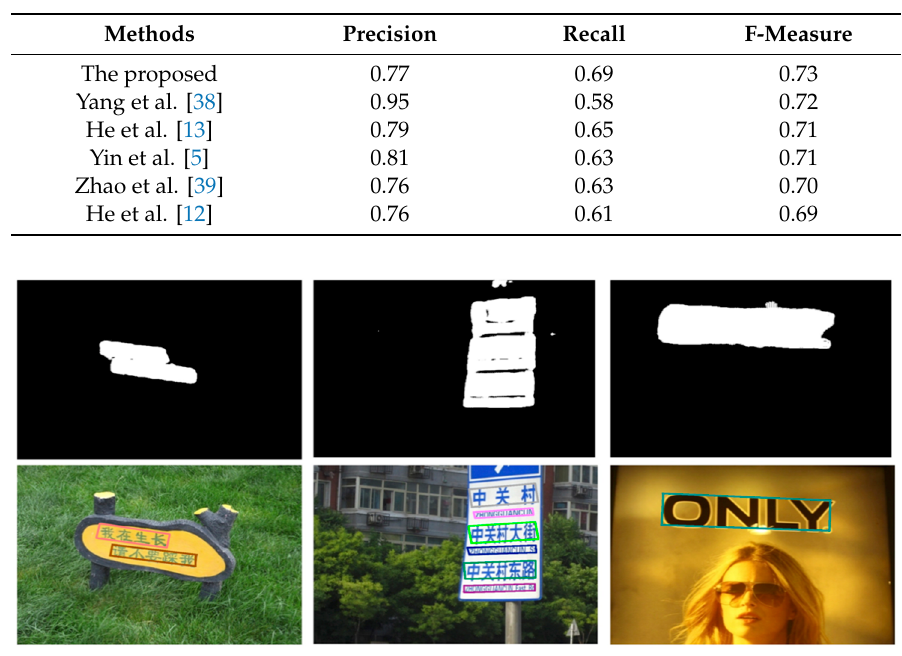
Figure 6. The performance of AT-text on the ICDAR2013 dataset. Images in the top row are text masks produced by the proposed segmentation model. Bounding boxes in the bottom row are our text detections. Table 4. Comparison of different text detection methods’ performance on the MSRA-TD500 dataset.